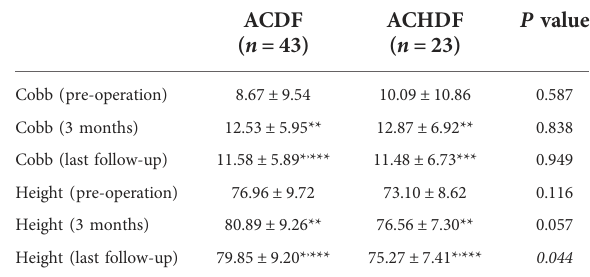
TABLE 4 The comparison of cobb angle (degree) and anterior column height (mm) of the two groups of ACDF and